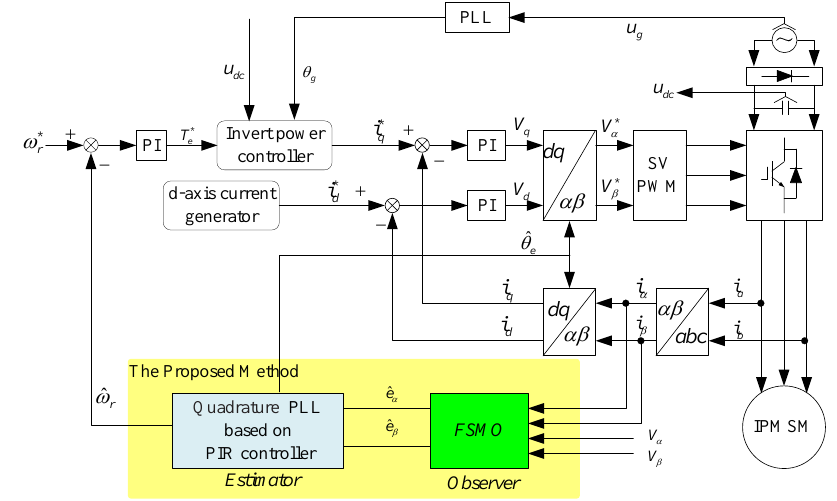
Figure 5. Interior permanent magnet synchronous motor (IPMSM) sensorless control with small DC-link capacitor.